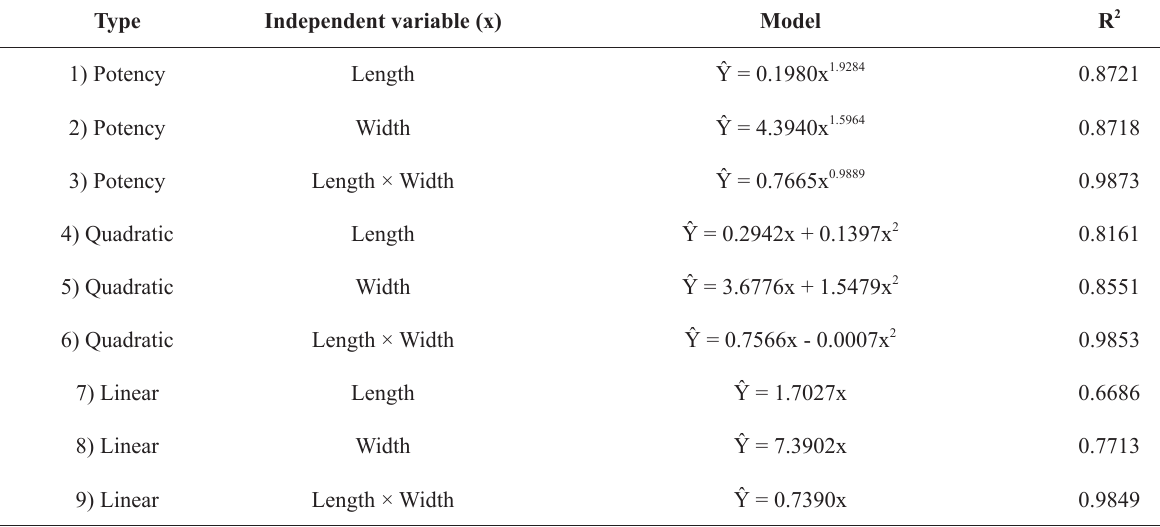
Potency, quadratic and linear type models for the determination of the real leaf area (Y) - using the length, width and/or the length times width product as independent variables (x) - and the determination coefficient (R 2 ) of each model, based on 3,200 leaves of Crotalaria juncea . Validation of nine models based on the indicators: linear coefficients (a), angular (b), linear correlation of Pearson (r) and determination (R 2 ), mean absolute error (MAE) and d index of Willmott (d), calculated based on observed and estimated 800 leaves leaf area of Crotalaria juncea in the 2014/15 harvest in Itaqui - RS - Brazil. Models generated with 3,200 leaves evaluated in four times by two sowing